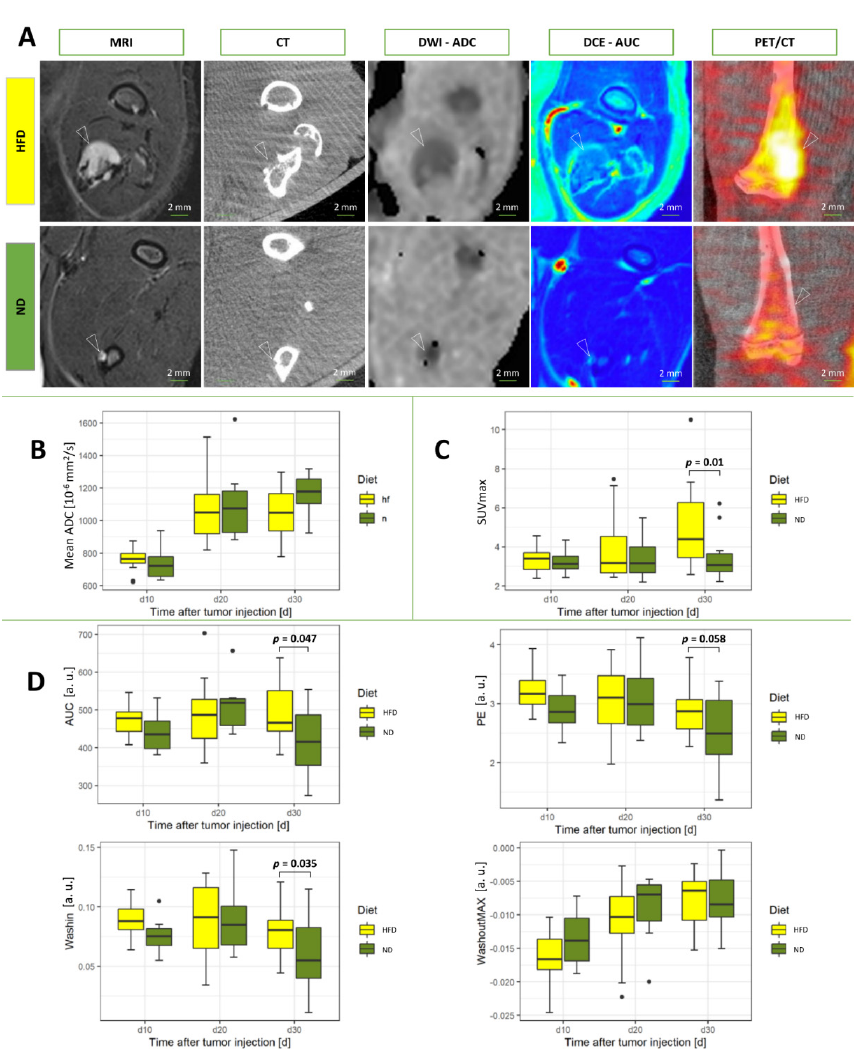
Figure 2. Functional and metabolic parameters of the main experiment from MRI and [ 18 F]FDG − PET/CT. ( A ) Representative images for day 30 of multiparametric MRI and PET/CT for both diet regimes. ( B ) Apparent diffusion coefficient (ADC) from diffusion-weighted imaging ( C ) Standardized uptake value (SUV) from positron emission tomography (PET). ( D ) Calculated parameters for the quantitative model of the signal intensity versus time curve of the dynamic contrast-enhanced (DCE) MR perfusion. White arrows indicate location of the bone metastases. Abbreviation a.u. stands for arbitrary units. Statistical analyses were performed with two-way ANOVA and Mann-Whitney-Wilcoxon U test. Significant values are defined as p < 0.05. Values of p are indicated up to a value of 0.15.